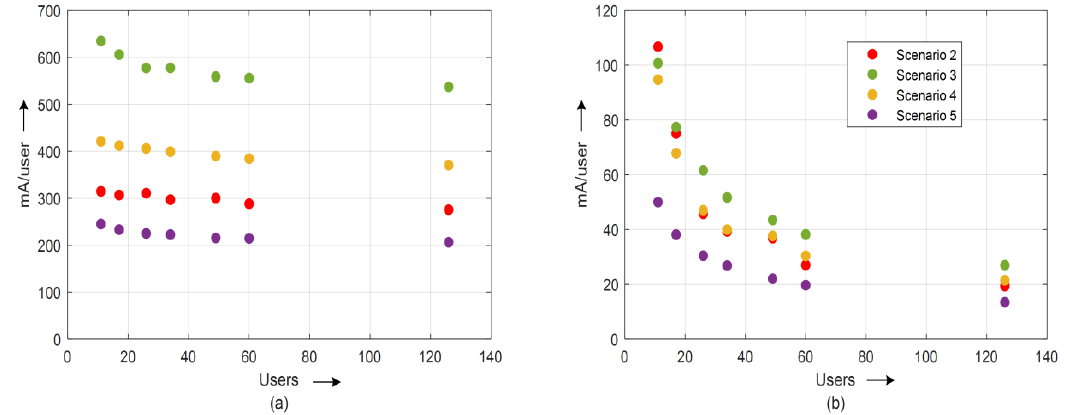
Figure 7. Normalized neutral harmonic currents under sinusoidal supply voltage: ( a ) 3rd harmonic and ( b ) 5th harmonic. Table 6. Ratio of reduction of normalized harmonic currents between 11 and 126 users.